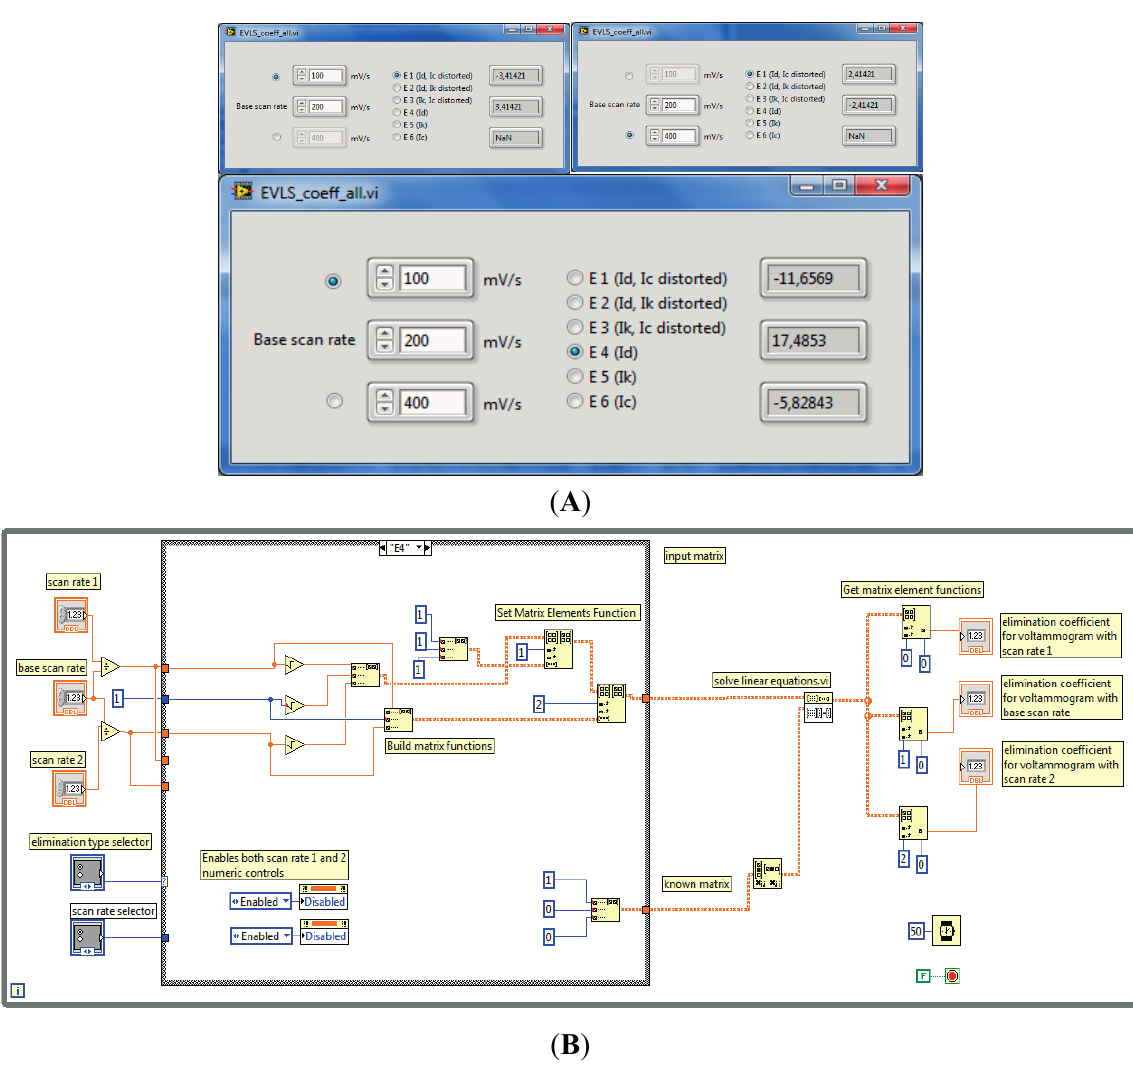
Figure 2. ( A ) Front panel of elimination coefficient calculator subroutine, upper left: calculation of elimination coefficients to eliminate kinetic current from the first two voltammograms and (upper right) second two voltammograms with indicated scan rate values. Below: calculation of elimination coefficients leaving only the diffusion current (Id) for the whole trinity of voltammograms; ( B ) Elimination coefficients’ calculator subVI. Annotated block